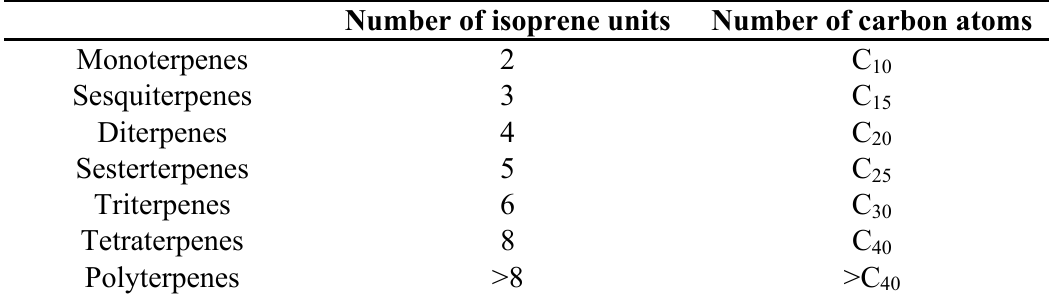
Figure 2. Isoprene unit.